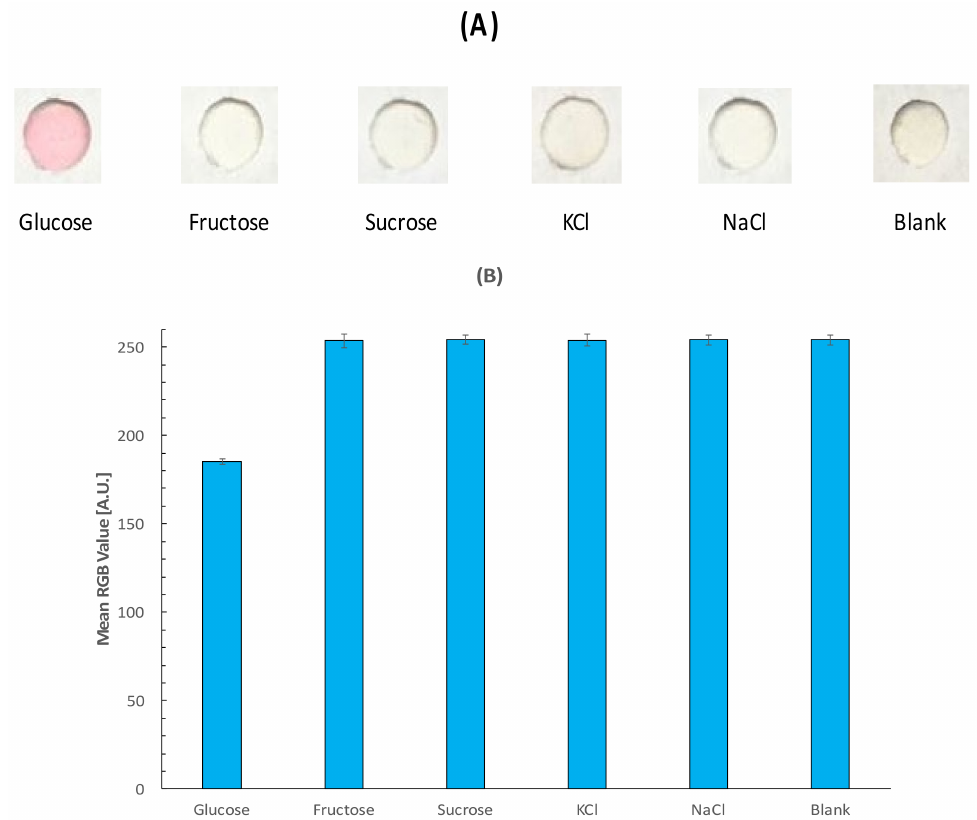
Figure 7. Selectivity test for the fabricated paper-based sensor with colorimetric visual detection ( A ) and RGB value ( B ).